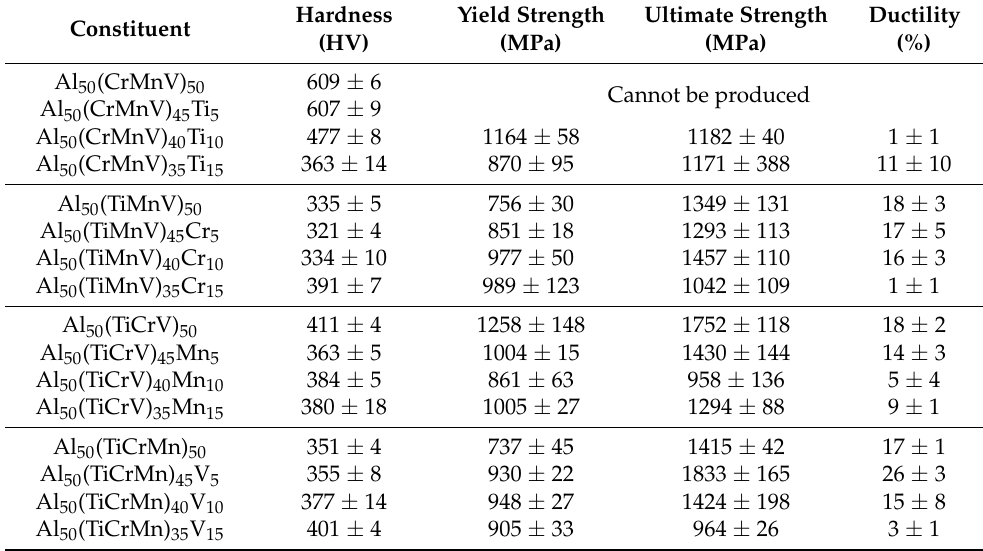
Table 1. Mechanical compressive properties of the Al 50 –Ti–Cr–Mn–V alloys. In summary, High Ti content in Al 50 –Ti–Cr–Mn–V MEAs can lead to a dual phase